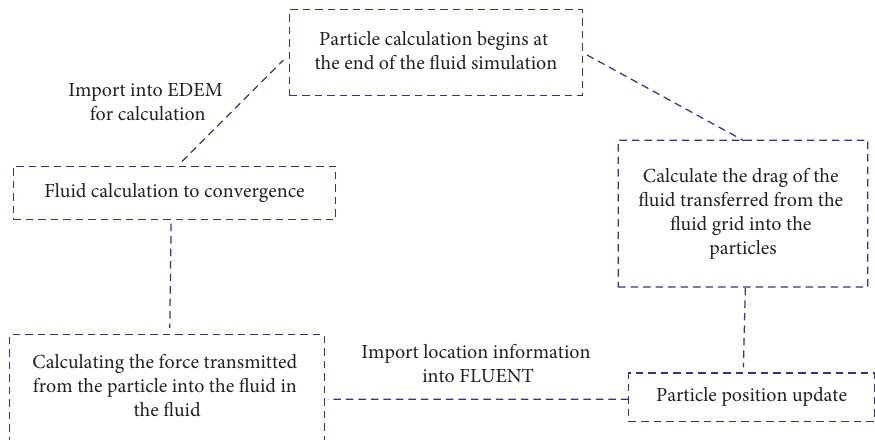
Figure 1: Coupled simulation flow chart.